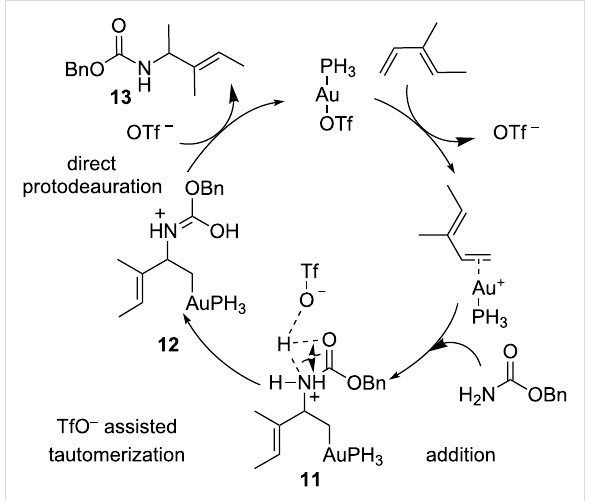
Figure 4: Postulated mechanism for the [Au(I)]-catalyzed hydroamina- tion of